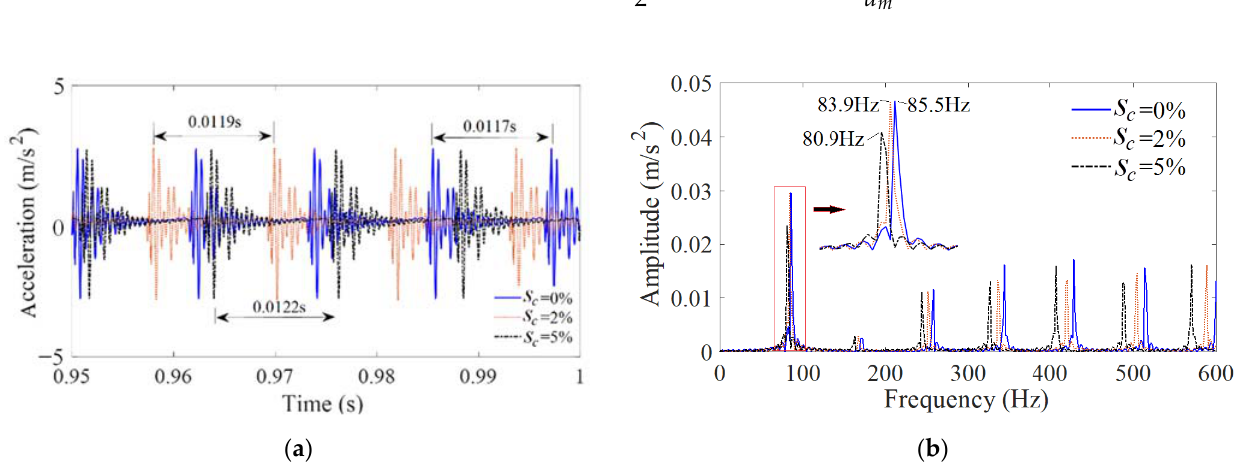
Figure 11. Dynamic response of ( a ) time-domain waveforms and ( b ) their spectrums under different cage slip S c ( μ m = 0.01, W = 2000 N, ω s = 2000 rpm).